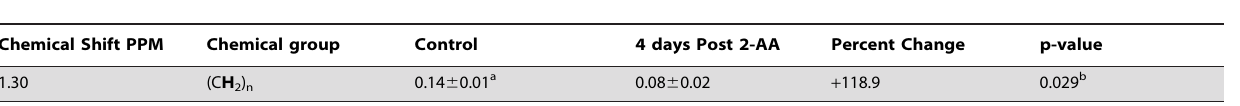
Table 2. 1 H NMR HRMAS analysis on gastrocnemius muscle from 2-AA treated and control